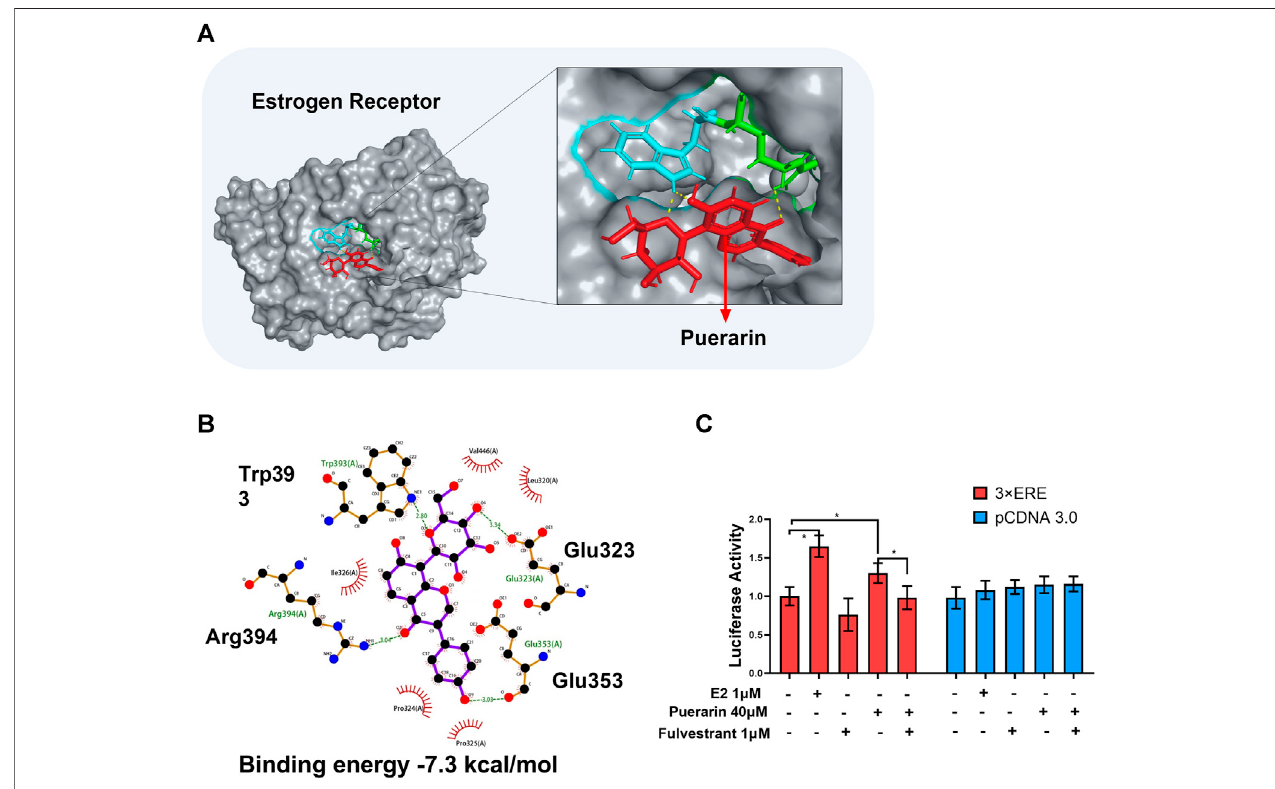
FIGURE 5 | In silico binding of puerarin to ER and the activation of the ER pathway. (A) Molecular docking of puerarin to ER structure. Puerarin was docked to ER structure (PDB:1X7R) using software Autodock vina. (B) 2D plot illustrating the interactions of puerarin with amino acid residues of ER. Hydrogen bonds were shown in greenlines. (C) AssayofER-mediated genetranscription.Followingtransfectionwith3xERE-TK-LucandpRL-TK,H9c2cellsweretreatedwithpuerarinorestradioland assayed for luciferase activity. The data were presented as mean ± SD ( n (cid:2) 3). * p < 0.05.